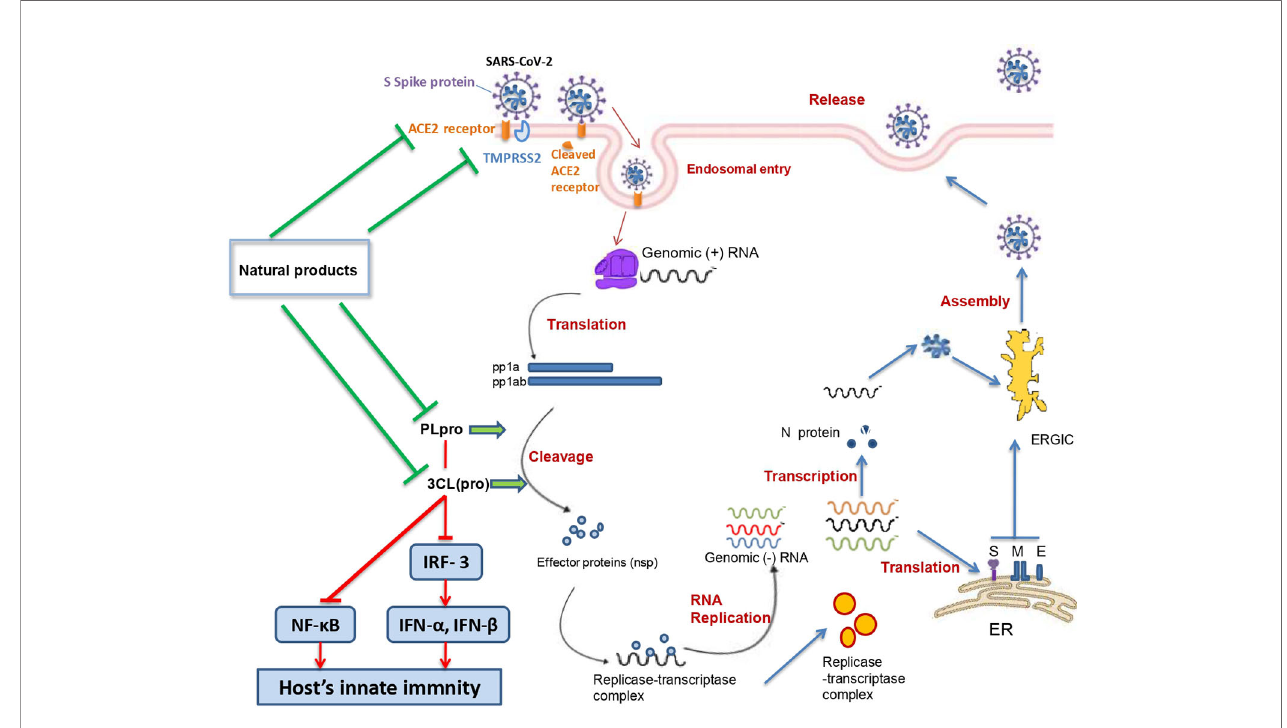
FIGURE 6 | Summary of possible anti SARS-CoV 2 actions of natural